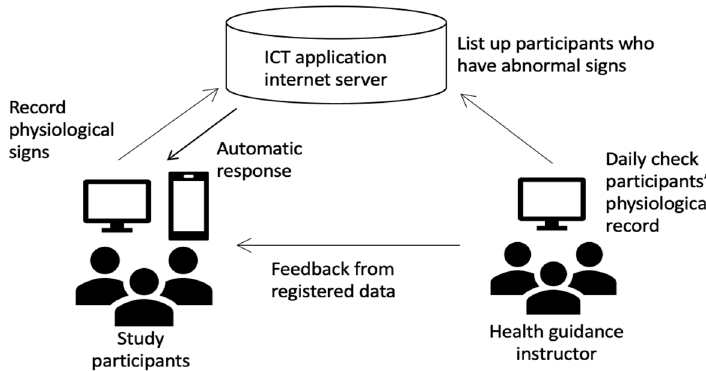
Figure 3. Health guidance process. Note: ICT: information and communication technology.